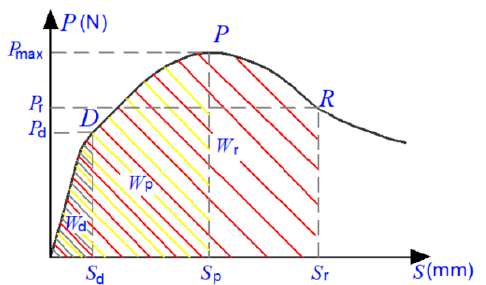
Figure 8. Typical diagram of characteristic pull-out load-slip curve [32].